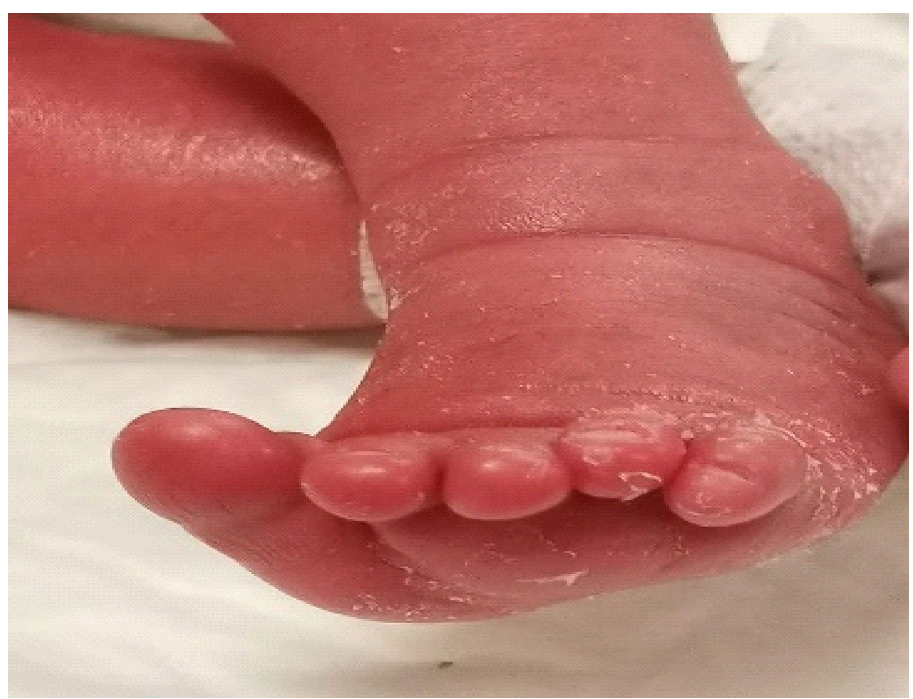
Fig. 2 Skin condition